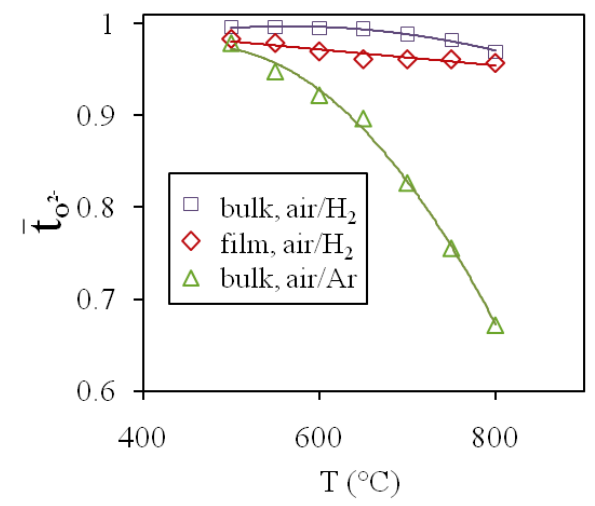
Figure 7. Temperature dependences of the e ff ective transport number of oxygen ions in the bulk and film SZY membrane exposed to p O 2 (air) / p O 2 (H 2 ) and p O 2 (air) / p O 2 (Ar) film SZY membrane exposed to p O 2 (air)/ p O 2 (H 2 ) and p O 2 (air)/ p O 2 (Ar) gradients.